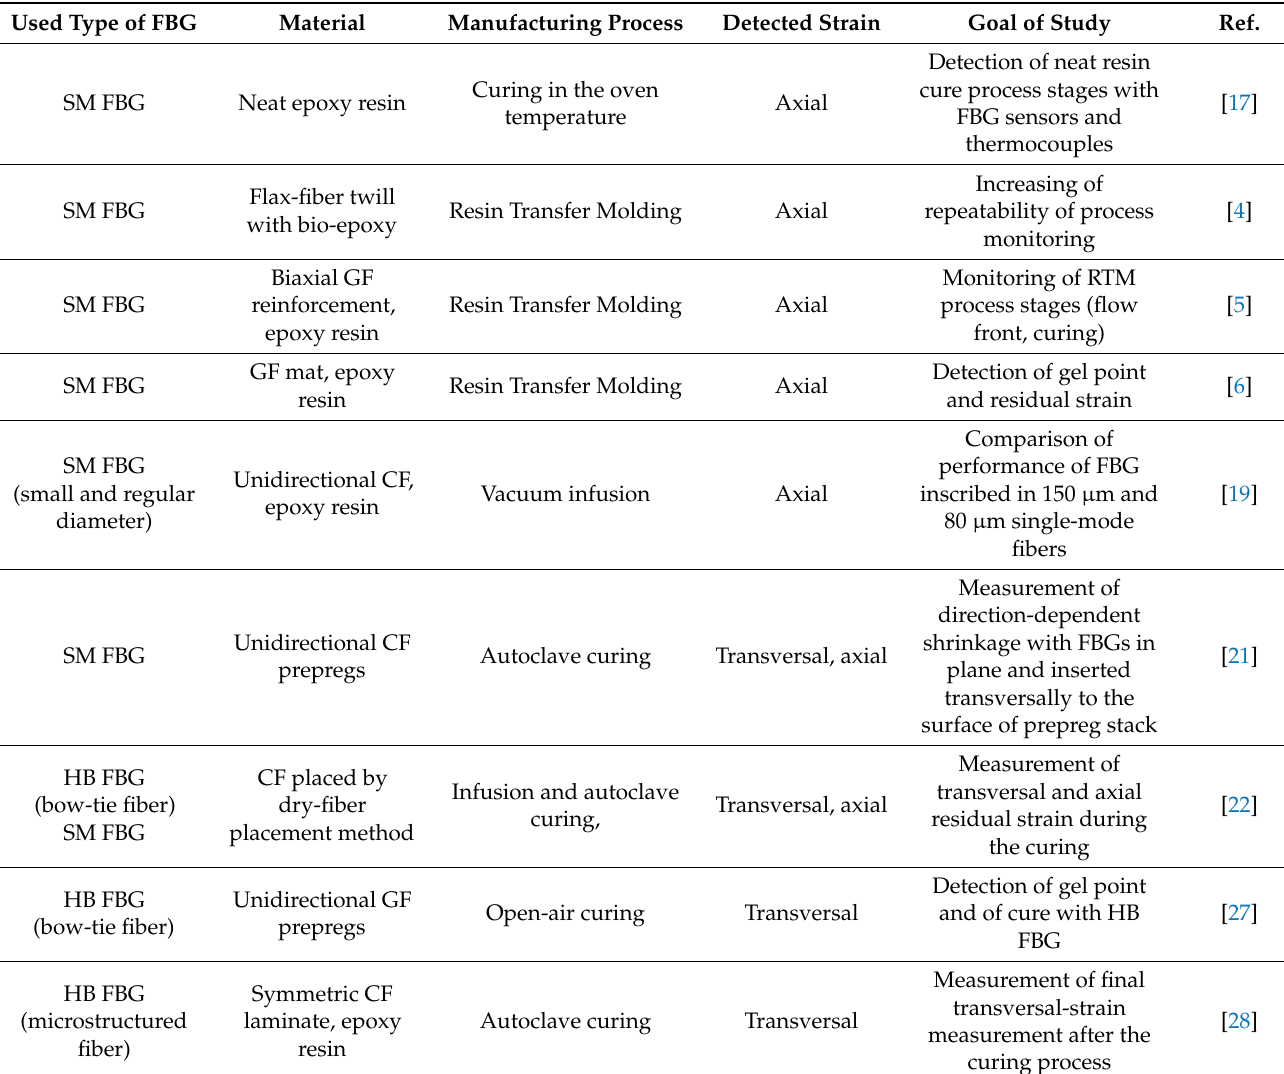
Table 1. Uses of FBG sensors to monitor composite manufacturing